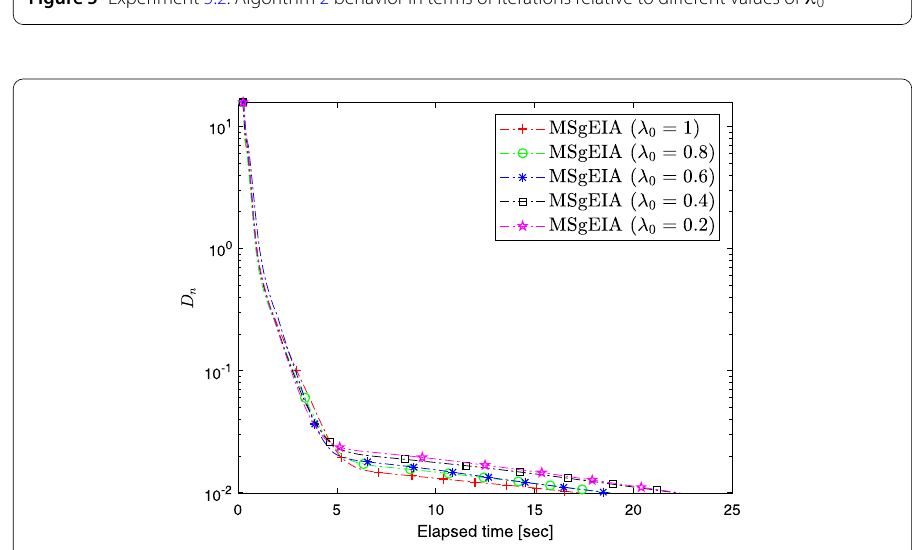
Figure 6 Experiment 5.2: Algorithm 2 behavior in terms of elapsed time relative to different values of λ